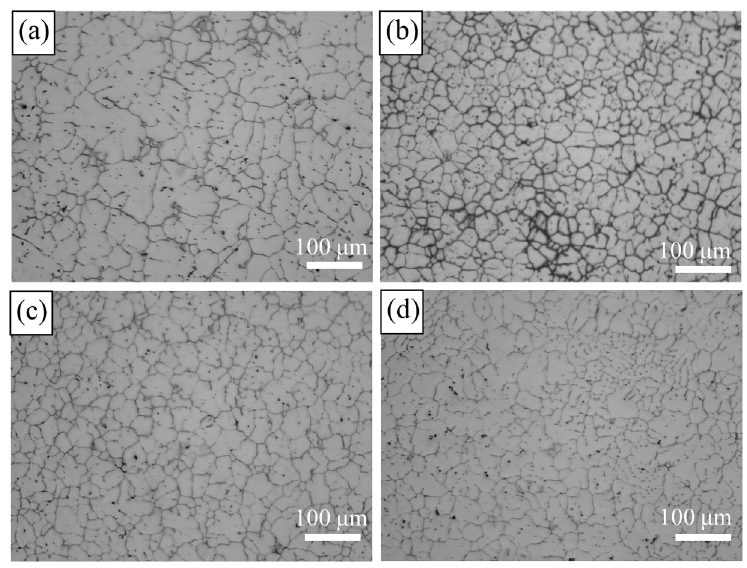
Figure 3. OM (optical microscope) images of alloys with different Ti contents: ( a ) 0.15 wt.%; ( b ) 0.20 wt.%; ( c ) 0.25 wt.%; ( d ) 0.30 wt.%. ( b ) 0.20 wt.%; ( c ) 0.25 wt.%; ( d ) 0.30